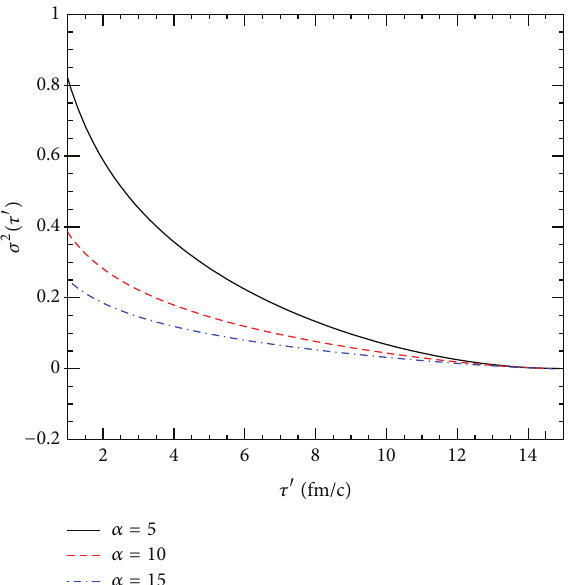
Figure 8: The width of 𝑔 QGP 𝑎𝑏 , Δ̃𝜂 , varies as a function of local scattering rate 𝛼 (color